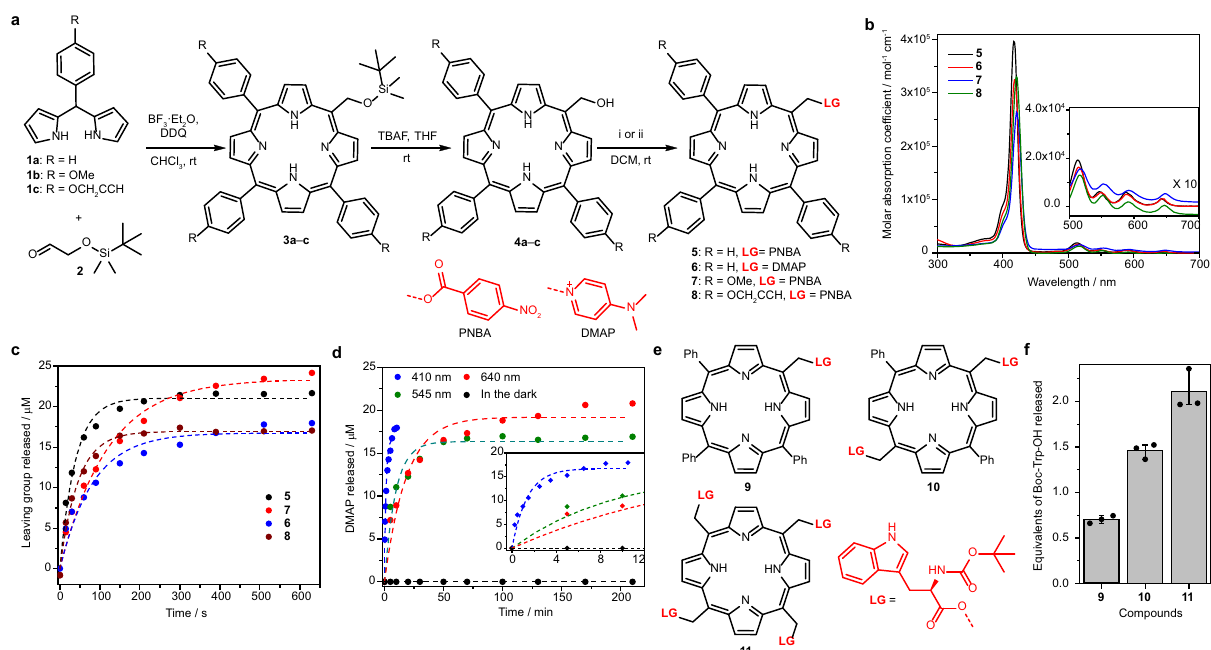
Fig. 2 Meso -methylporphyrin as a versatile PPG scaffold: synthesis and photochemistry. a Synthesis of meso -methylporphyrin derivatives. i: PNBA, DMAP, DCC, 20 °C. ii: mesylchloride, DMAP, 20 °C. b Absorption spectra of PNBA- and DMAP-caged meso -methylporphyrins (3 µ M, aerated DMSO). Inlet: a 10-fold magni fi cation of the Q-band regions. c Photorelease of leaving groups from meso -methylporphyrin derivatives 5 – 8 (25 µ M, degassed DMSO, λ = 410 nm, 40 mW cm − 2 ; HPLC-MS analysis). d Photolysis of 6 (25 µ M, degassed DMSO) at λ irr 640 nm (67 mWcm − 2 ). Inlet: focus on early time points. e Structures of mono-, di- and tetra - N α -Boc-(L)-Trp caged meso -methylporphyrin derivatives ( 9 – 11 ). f Quanti fi cation of the photorelease of leaving groups from 9 – 11 ( λ irr = 410 nm, 40 mW cm − 2 , HPLC-MS analyses). Averages from three experiments are shown; error bars represent the standard